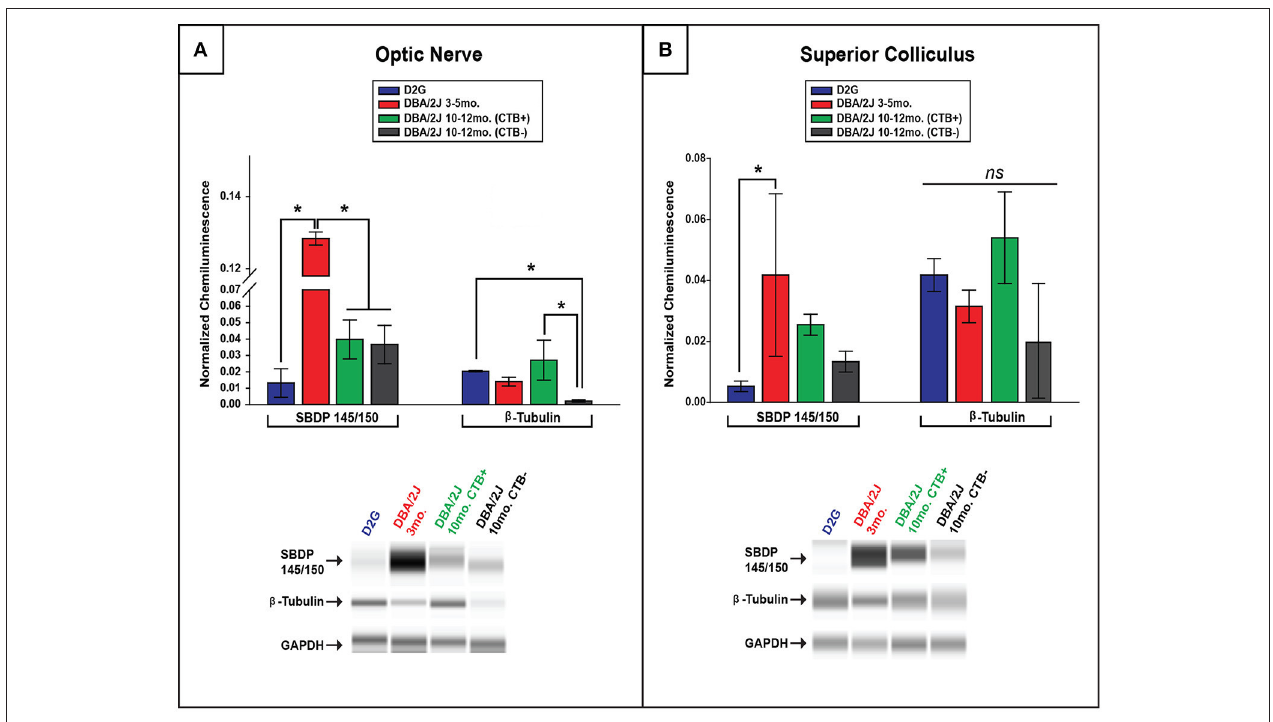
FIGURE 4 | Spectrin breakdown product (SBDP) 145/150 is elevated in young DBA/2J ON and SC while β -tubulin is decreased in a transport-dependent manner in pathologically-aged ON. (A) Chemiluminescence-based quantification using ProteinSimple Wes technology illustrates significantly higher levels of SBDP(145/150) within ON of D3-5 mice compared to all other groups, with no differences seen in pathologically-aged (10–12 months.) DBA/2J mice regardless of transport outcome. Bar graph (top) shows SBDP145/150 and β -tubulin normalized to GAPDH (a housekeeping gene marker), while corresponding examples of automated western output are shown below for ON. Importantly, a significant decrease in β -tubulin was observed in pathologically-aged ON associated with zero anterograde transport to the corresponding SC compared to controls and D10-12 mice with intact transport. (B) A significant elevation in SBDP chemiluminescence was observed in D3-5 SC compared to D2G controls (B) , with no differences in collicular β -tubulin elucidated. Bar graph (top) shows SBDP145/150 and β -tubulin normalized to GAPDH, while corresponding examples of automated western output are shown below for SC. (Refer back to Figure 1 to see β -tubulin loss using immunofluorescence.) Error bars depict SEM. Asterisk indicates that groups are significantly different from bracketed comparison ( p <